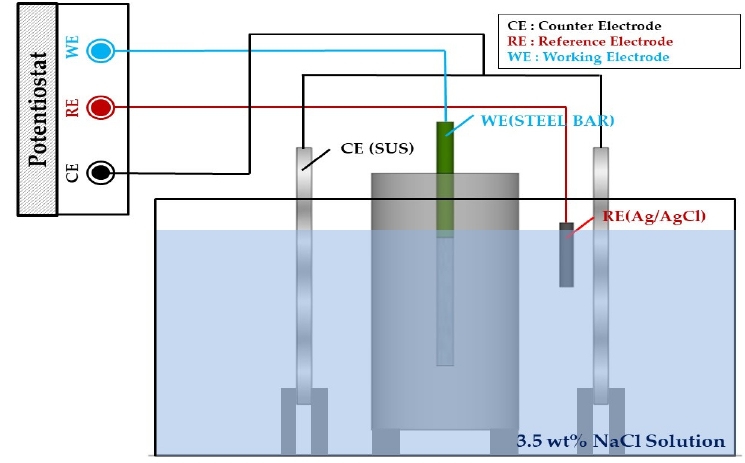
Figure 5. Experimental setup for the EIS experiment.